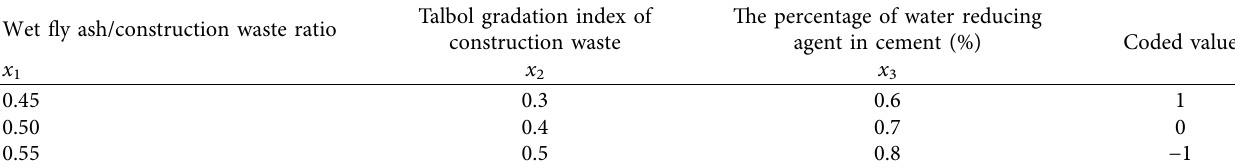
Table 3: Actual and coded values of the experimental factors. Wet fly ash/construction waste ratio